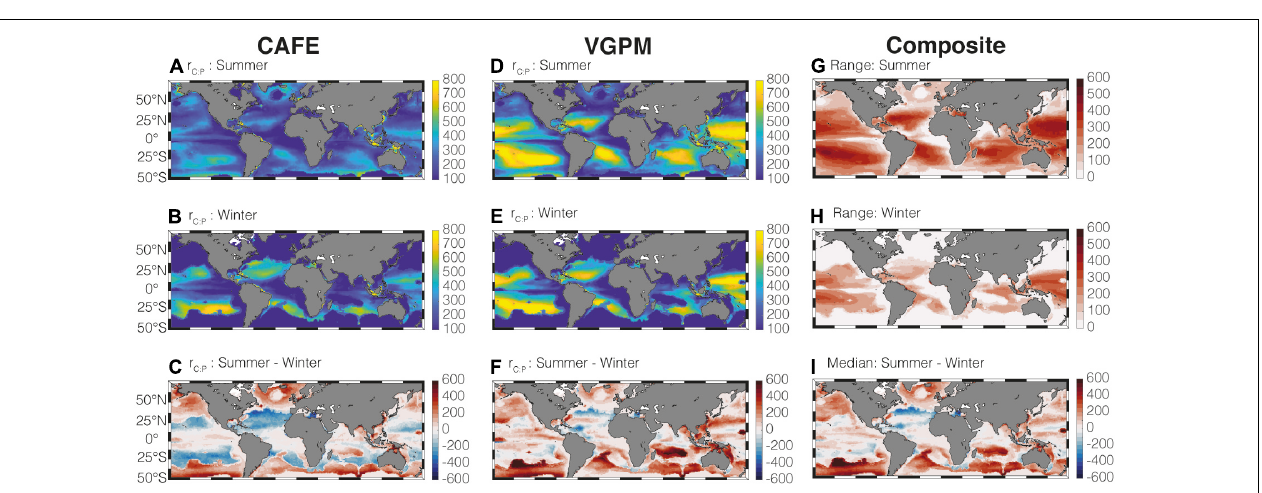
FIGURE 3 | Global climatology of summer and winter average CAFE-informed r C : P (A–C) and VGPM-informed r C : P (D–F) in the surface mixed layer. r C : P is in molar units. Panels (G,H) show the maximum range in the four satellite-informed r C : P for summer and winter, respectively. Panel (I) shows the seasonal change in median r C : P